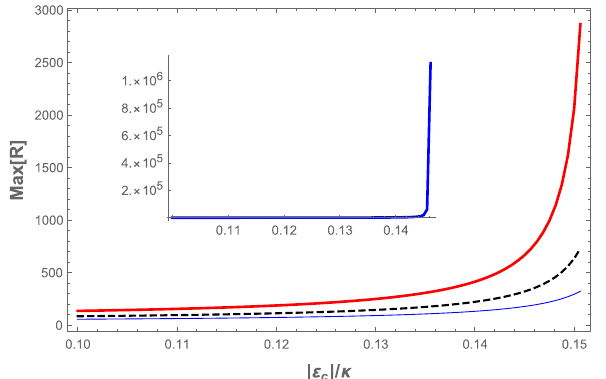
Figure 6. (Color online) The maximum value of the cavity power reflection coefficient at the signal frequency versus the normalized coupling laser pumping rate ( | ε c | /κ ) for different values of the s -wave scattering frequency: ω sw = 3 ω R (red thick curve), ω sw = 4 ω R (black dashed curve) and ω sw = 5 ω R (blue thin curve). The inset shows M ax [ R ] versus | ε c | /κ for ω sw = ω R . The other parameters are the same as those of Fig.